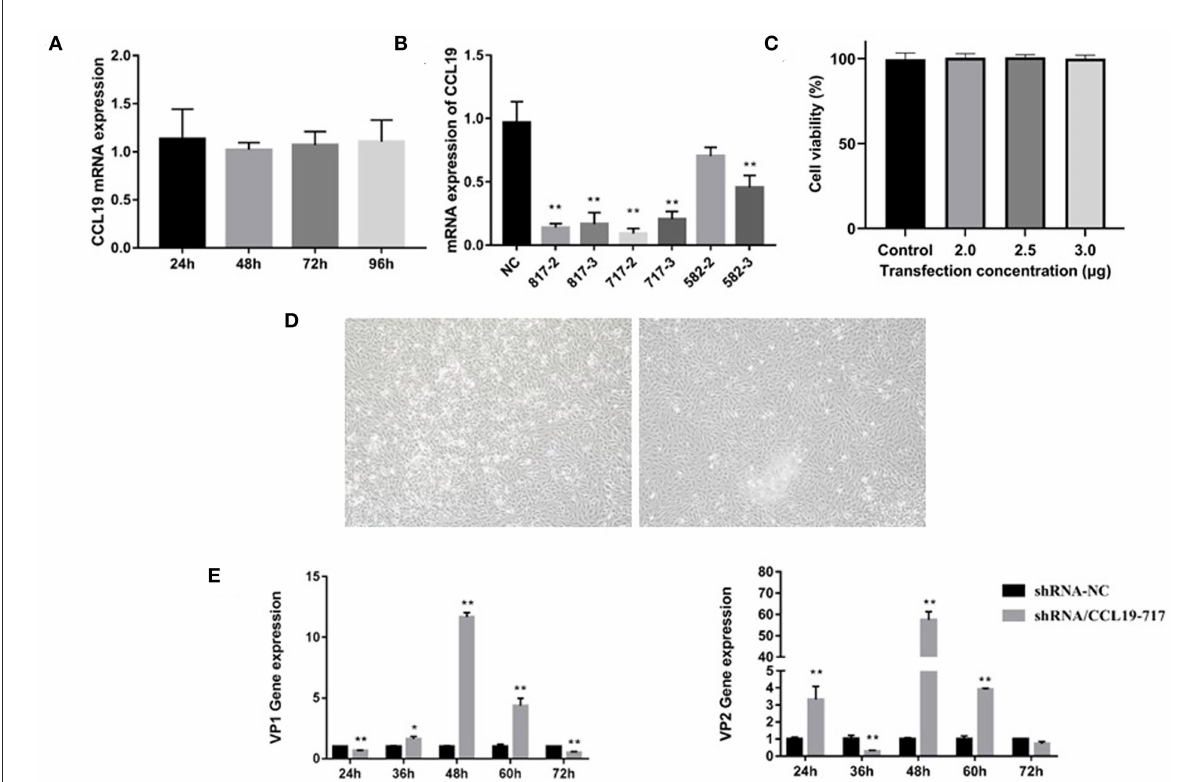
FIGURE4 siRNA knockdown of CCL19 promotes IBDV replication. (A) Gene expression levels of CCL19 in DF1 cells. (B) The efficiency of different CCL19-siRNA. (C) Cell viability at 2h after si717 transfection. (D) Cell morphology at 24h after si717 transfection. (E) Gene expression levels of VP1 (left) and VP2 (right) at 24, 36, 48, 60, and 72h post-infection with IBDV B87 strain in si717 group compared with NT control group. * or ** indicates that there were significant differences of VP1, VP2, and CCL19 gene expression levels between siCCL19 and NT groups ( p < 0.05 or p <